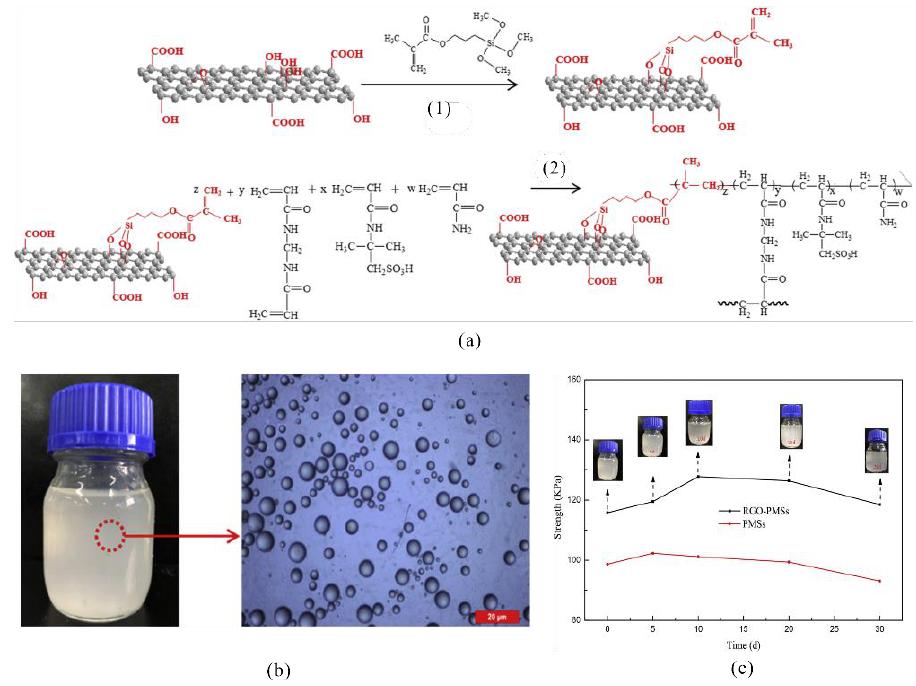
Figure 7. Preparation mechanism, microscopic image, and strength variations of modified GO polymer microspheres; ( 1 ) synthetic routes of FRGO; ( 2 ) synthetic routes of RGO-PMSs; ( a ) synthetic routes of GO polymer microspheres; ( b ) morphology of modified GO polymer microspheres; ( c ) strength of polymeric microspheres versus aging time [50]. (Reprinted/adapted with permission from Ref. [50]. 2020, D u , et al”) .